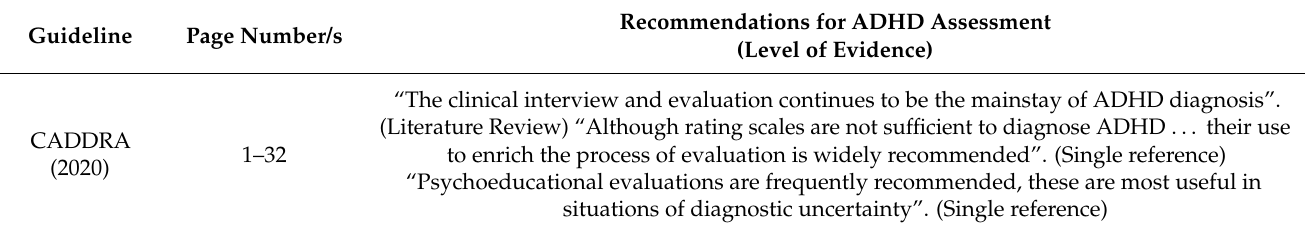
Table 4. Summary of ADHD assessment recommendations in CADDRA